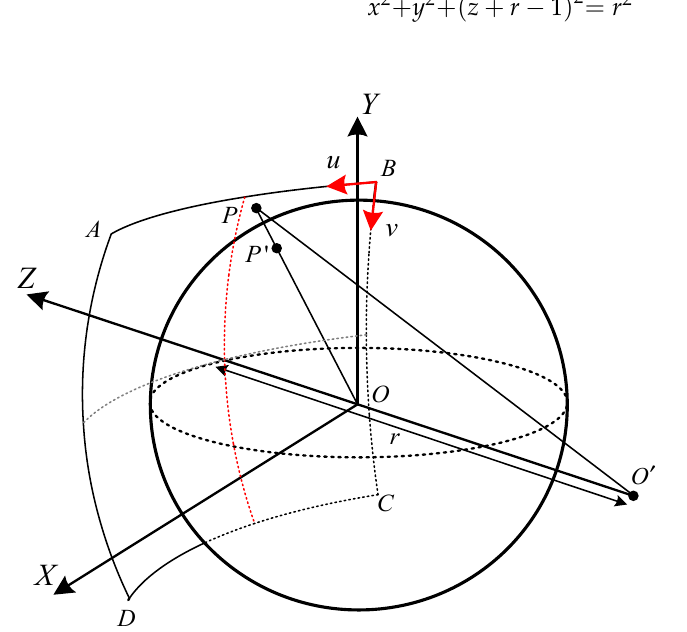
Figure 9. Curved UV surface, which is the tangent surface for the unit sphere. In Figure 10, the red curve represents the cross-section of the proposed UV surface, where F v is the vertical FOV and F OUT is the corresponding vertical angle at the center O (cid:48) v of the outer sphere to cover the surface that is generated by applying F v at the center O of the unit sphere. The relationship between F v and F OUT v